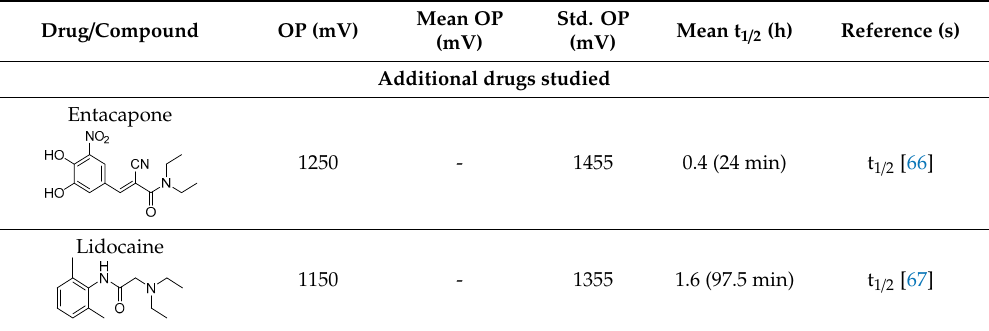
Figure 1. ( a ) Relationship between OP and half-life of all compounds; ( b ) Relationship between standardised OP (N.H.E.) and half-life. Key: * = additional drugs studied and number after the drug indicates which entries from Table 1 were standardized.